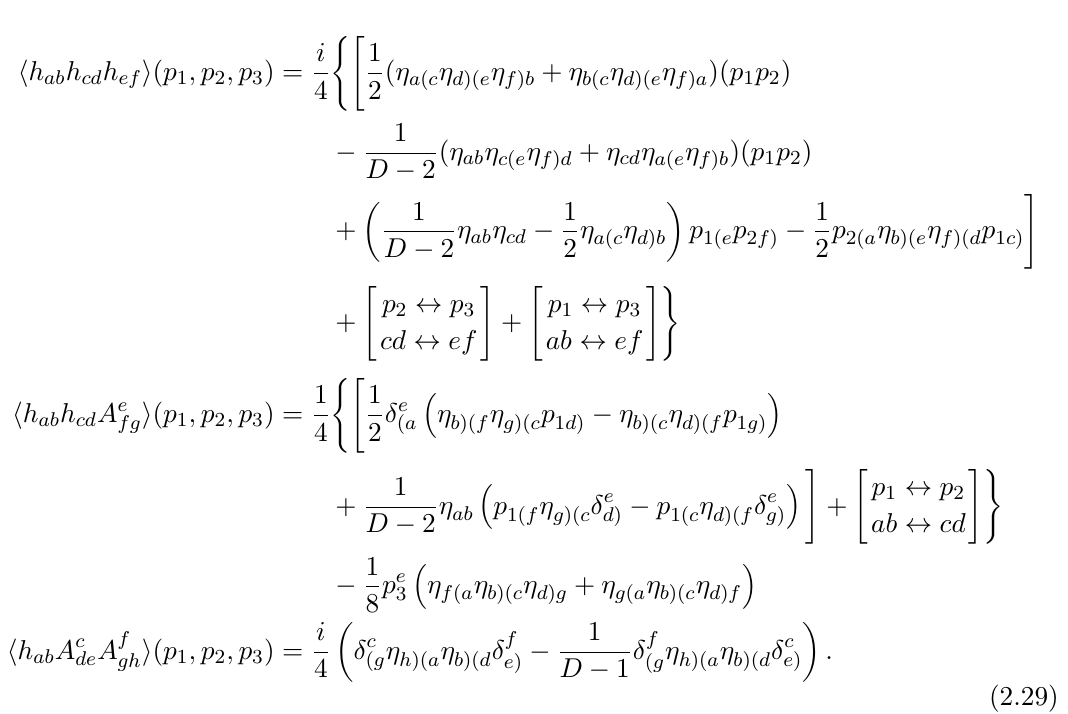
to A d . Meanwhile, the interaction vertices are bc ef